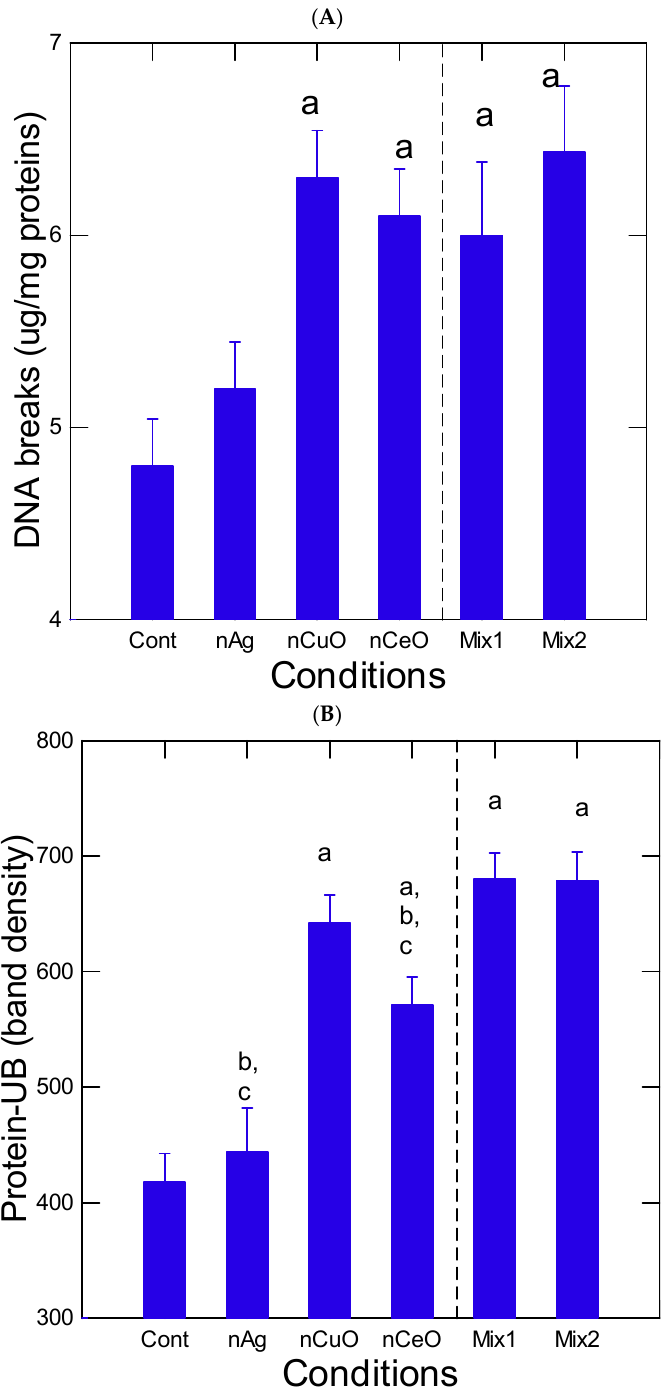
Figure 3. Hepatic DNA and protein damage in trout exposed to the nanoparticles. The data represent the mean with the standard error for DNA damage ( A ) and protein ‐ ubiquitin tagging ( B ). The Mix1 consists of 20 μ g/L of nAg and nCuO and 5 μ g/L of nCeO giving a net concentral of 37 μ g/L. The Mix2 consists of 50 μ g/L of nAg and nCuO and 10 μ g/L nCeO giving a net concentration of 110 μ g/L. The letter a indicates significance relative to controls, b significance relative to Mix1, and c relative to Mix2.